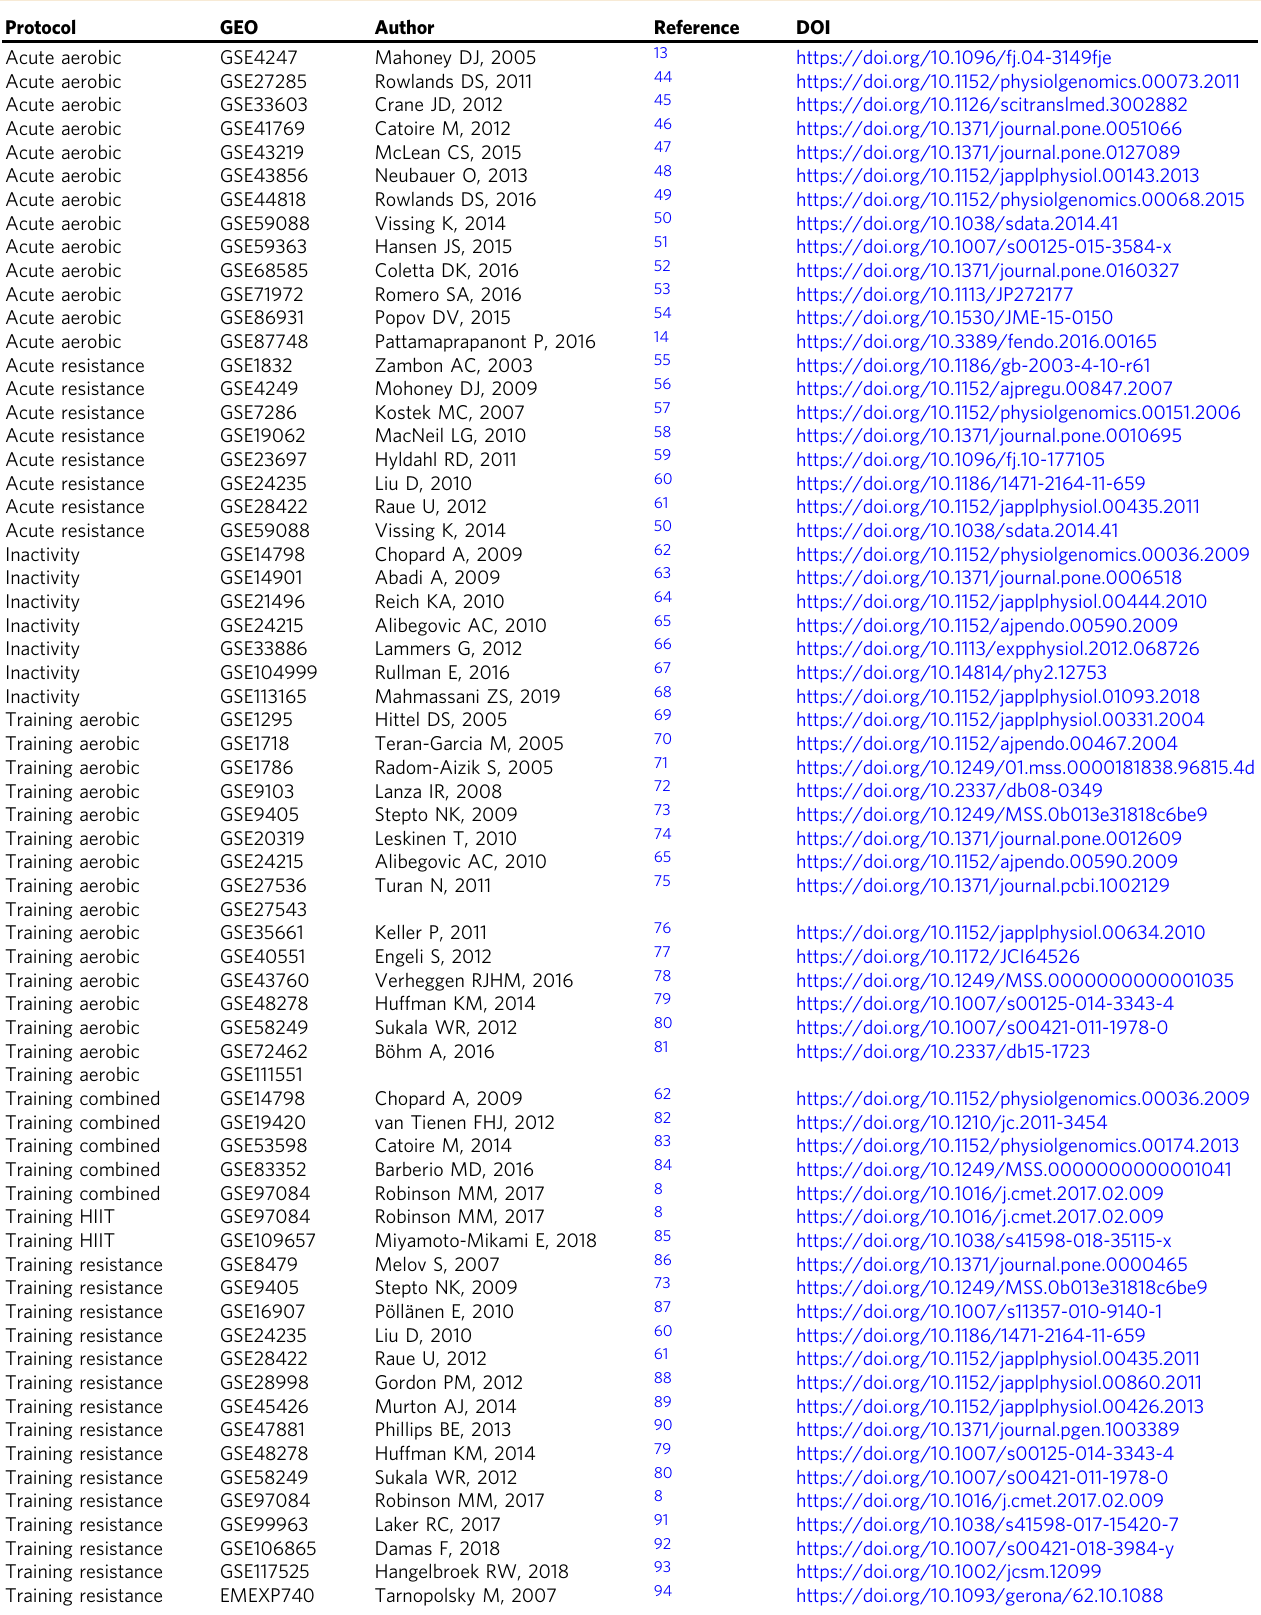
Table 2 Studies included in the MetaMEx